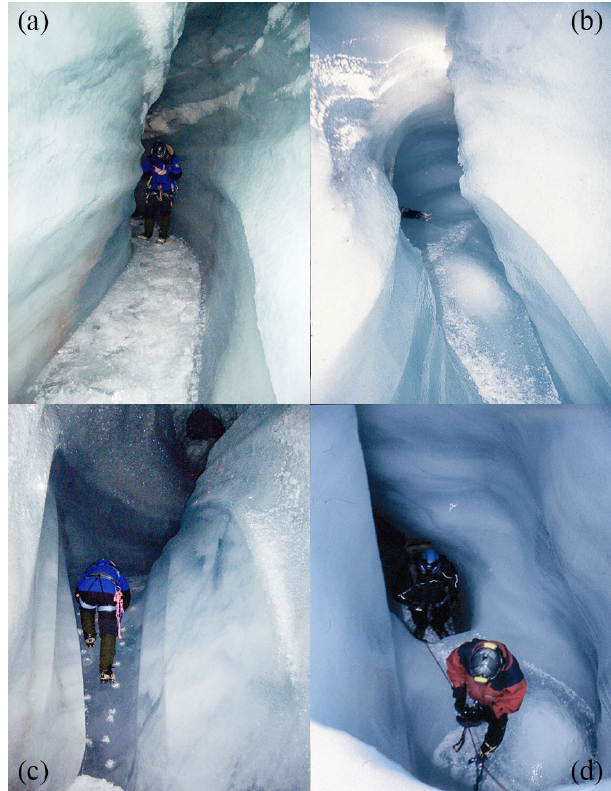
Figure 4. Illustration of various englacial channel forms: (a) low gradient (LG) reach, (b) medium gradient (MG) reach (see glove for scale), (c) knickpoint (KP) with sloping step riser, (d) knickpoints (KP) with vertical step risers. For (c) and (d) compare to KP types 1 and 2 depicted in Fig. 1. For all photos, flow direction is away from the